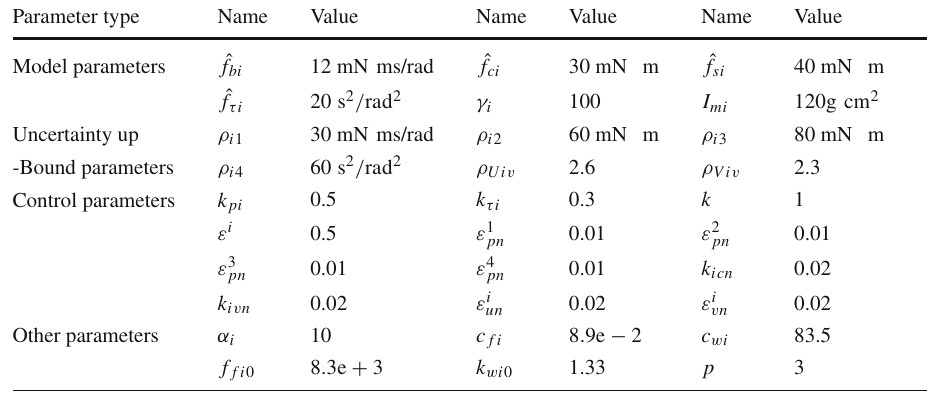
Table 2 Performance comparisons in each control method Control method selection